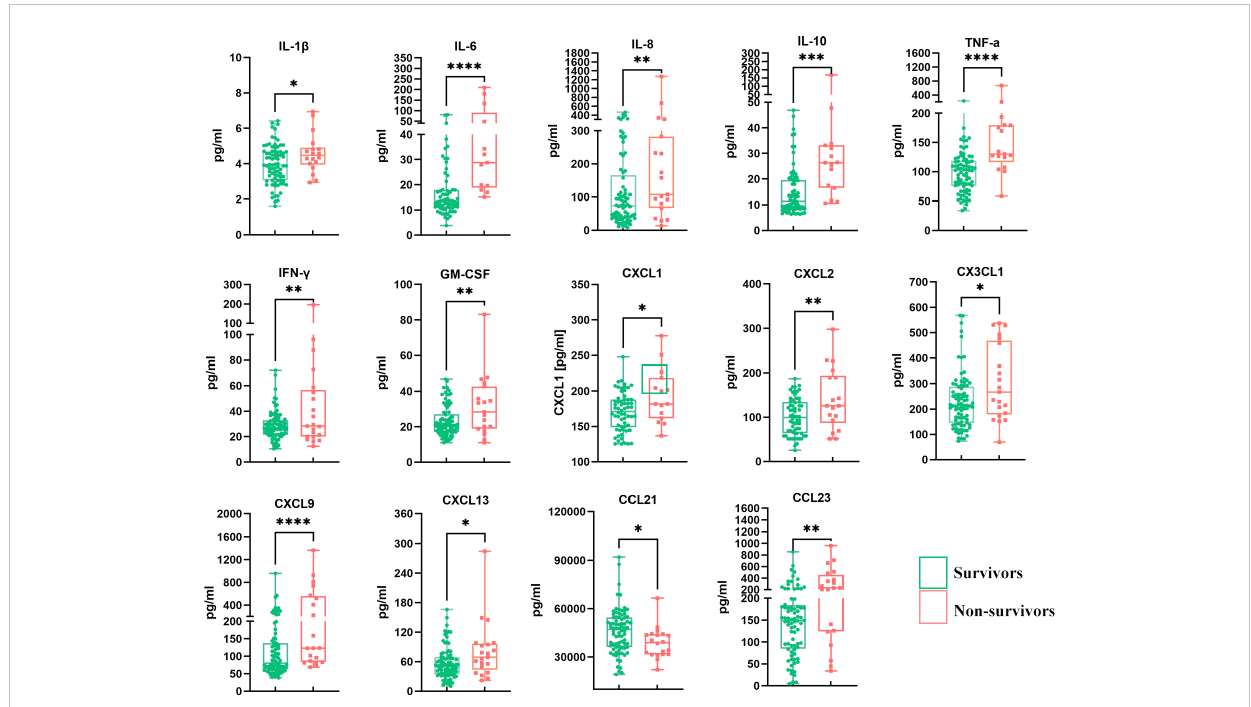
FIGURE 2 Comparison of the 14 differentially expressed serum cytokines/chemokines between survivors and non-survivors. * p < 0.05, ** p < 0.01, *** p < 0.001, **** p <